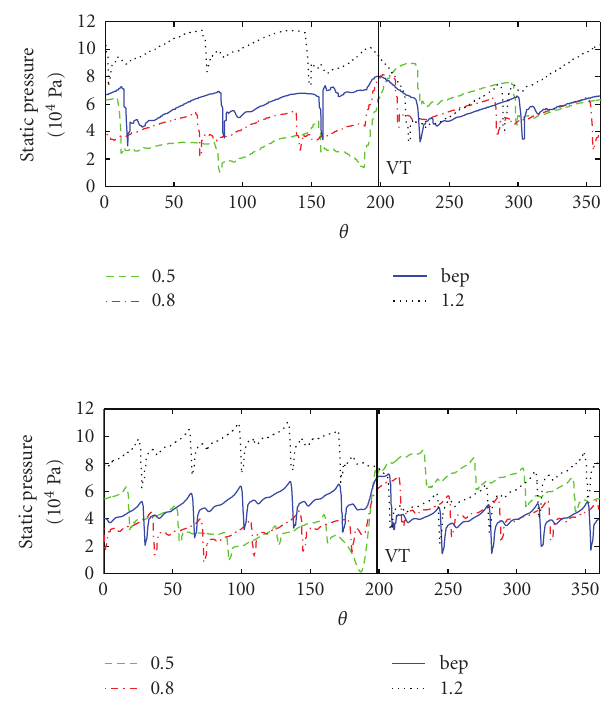
Figure 12: Static pressure distribution at the original (top) and splittered (bottom) impeller periphery at z = 0 at 0.5 q bep , 0.8 q bep , q q = volute tongue angular position. bep , and 1.2 bep . VT